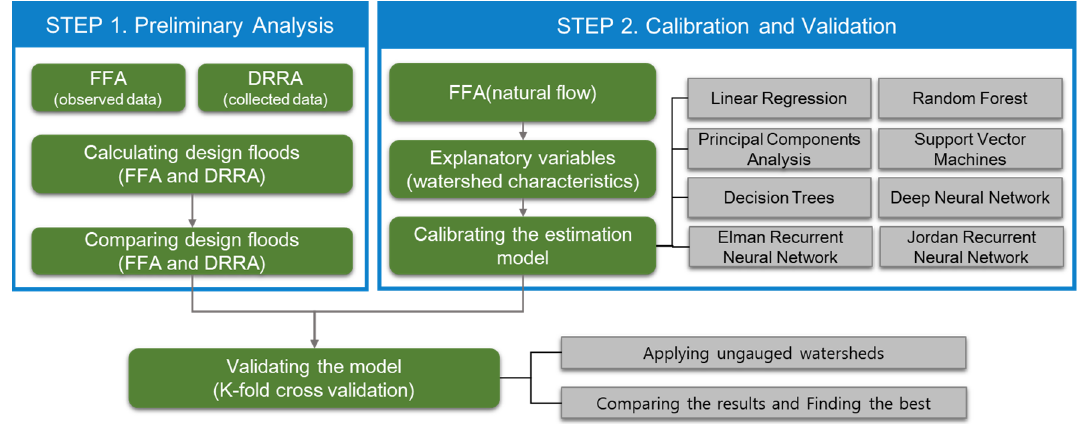
Figure 1. Flow chart of the study.